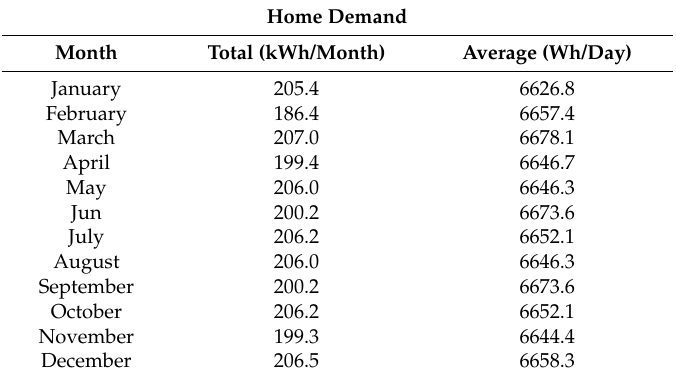
Table 3. Electric demand from a single family home.